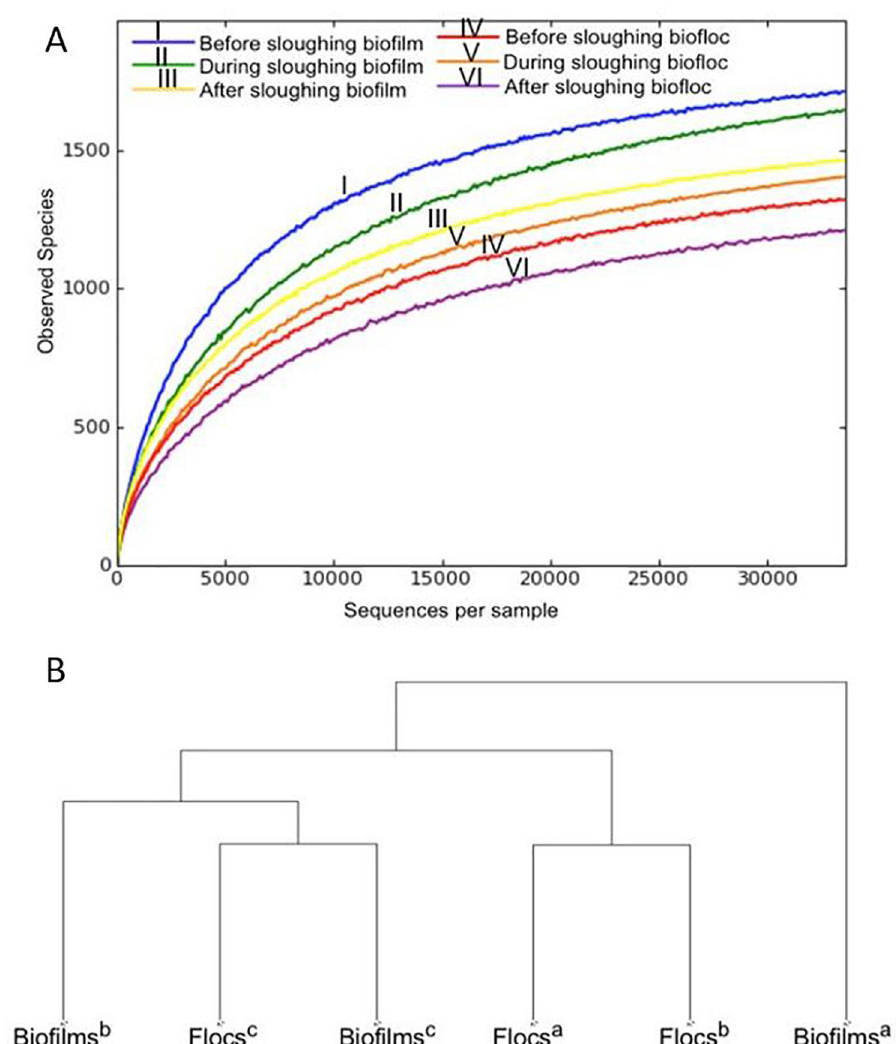
Fig 7. Microbial community diversity in FS IFAS system: (a) α -diversity (using observed species metrics) in biofilms and flocs before, during, and after biofilm sloughing; (b) β -diversity (weighted UniFrac) in biofilms and flocs determined by 16S rRNA gene sequencing, (a) before sloughing, (b) during sloughing and (c) after sloughing.